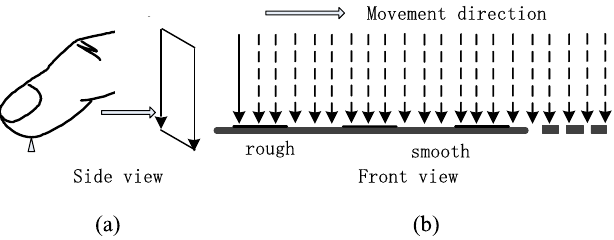
Fig. 8. Illustration of (a) the concentration of fi ngertip on the texture rendering plate and (b) the generated grating texture feeling. fi ngertip down on the texture rendering plate when a fi nger